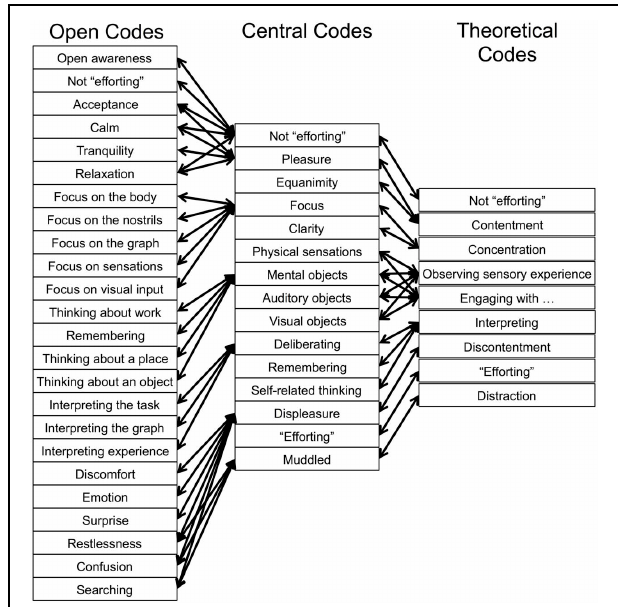
FIGURE 1 | Representation of the open codes, central codes, and theoretical codes derived from self-report and neurofeedback graph data using grounded theory